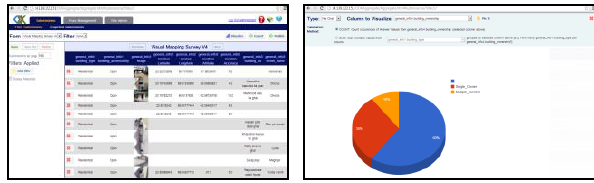
Figure 13-14. ODK Aggregate for data storage and analysis